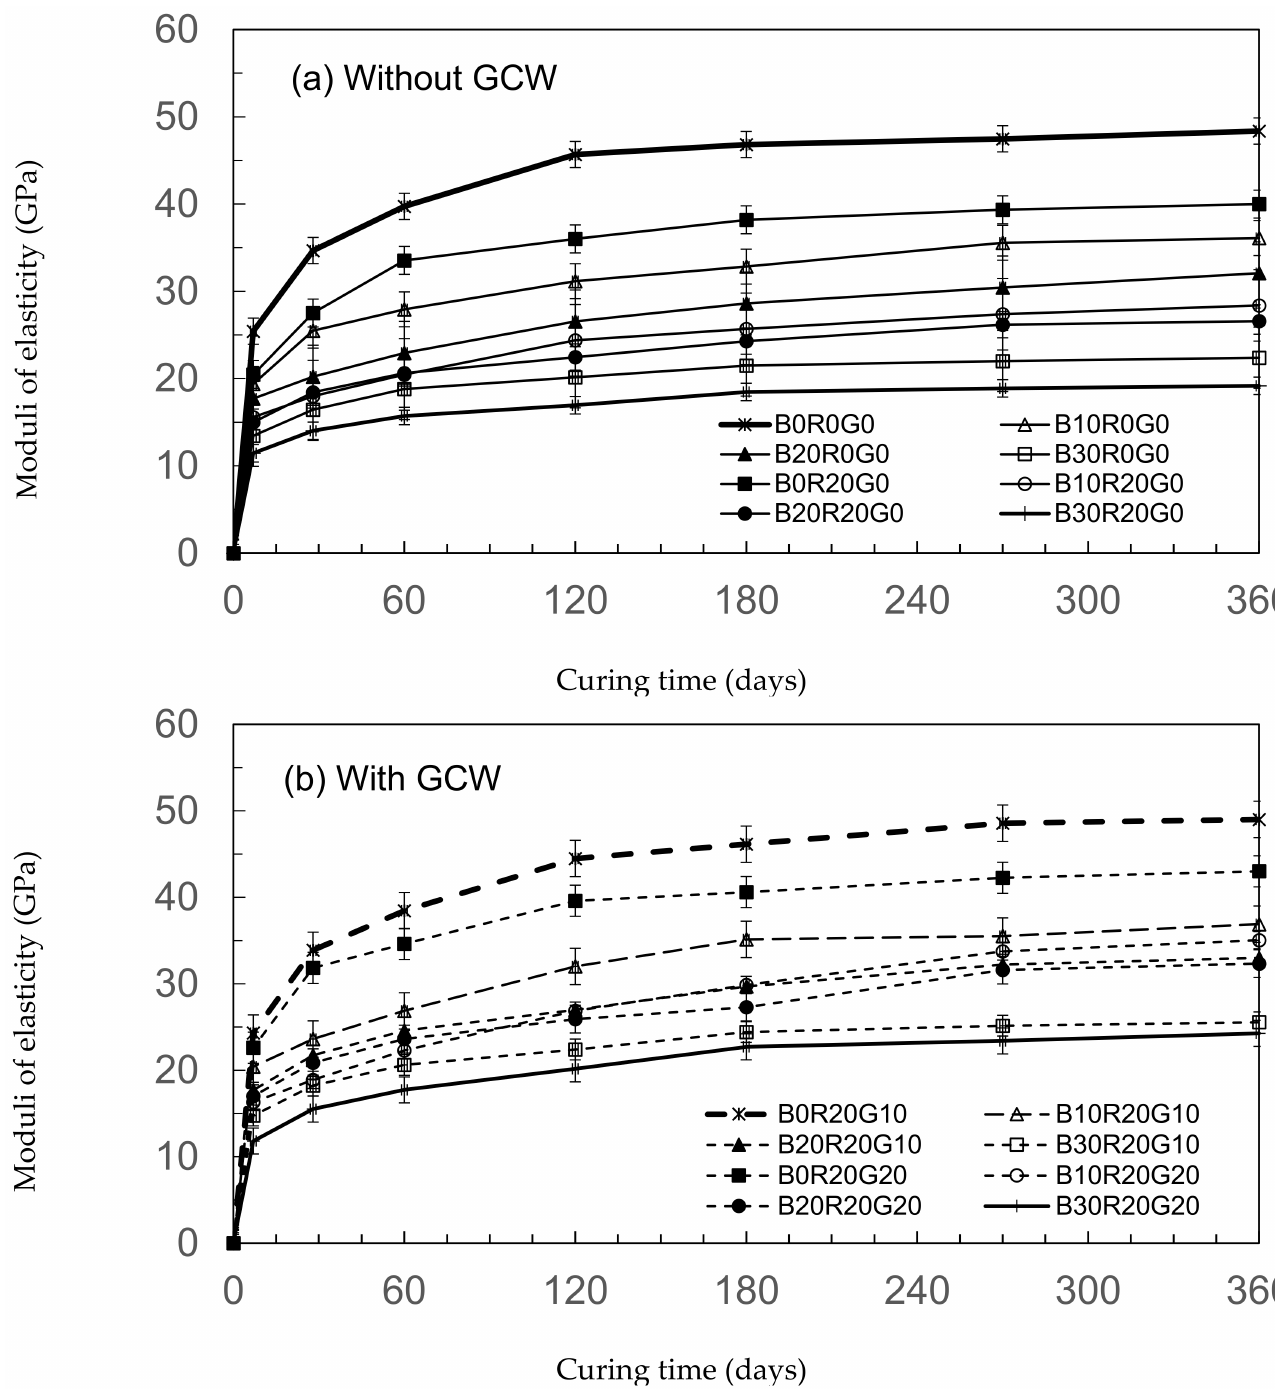
Figure 6. Moduli of elasticity of gSCC. ( a ) without GCW and ( b ) with